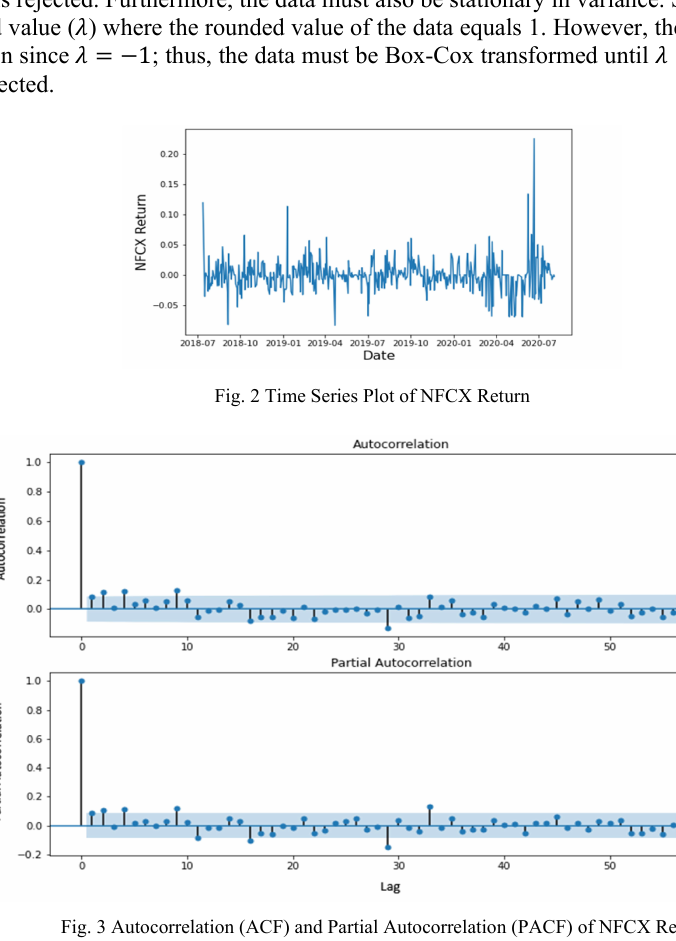
Fig. 3 Autocorrelation (ACF) and Partial Autocorrelation (PACF) of NFCX